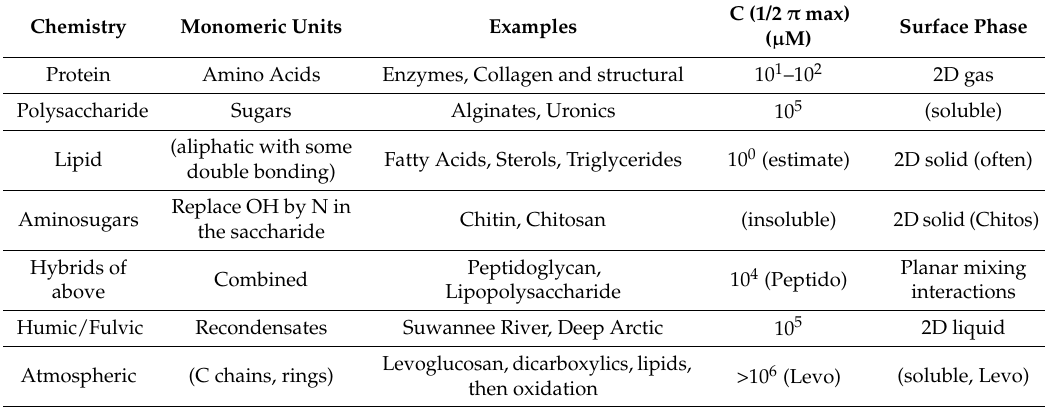
Selected families of marine biomacromolecules with representative half saturation concentrations for adsorption, and corresponding 2D phase states within the microlayer